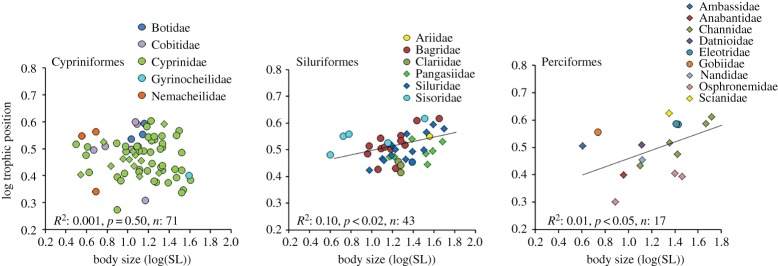
Body size–TP relationships of fish assemblages among three taxonomic orders. Families within each taxonomic order are colour coded. Circles represent benthic species, diamonds represent pelagic species.